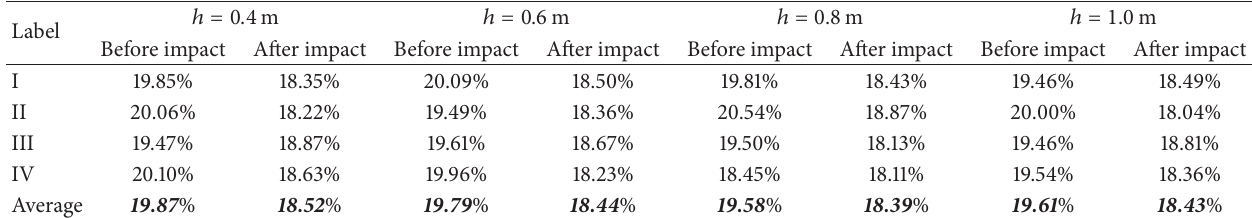
Table 4: Water content of soils below the bottom of the impacted holes.